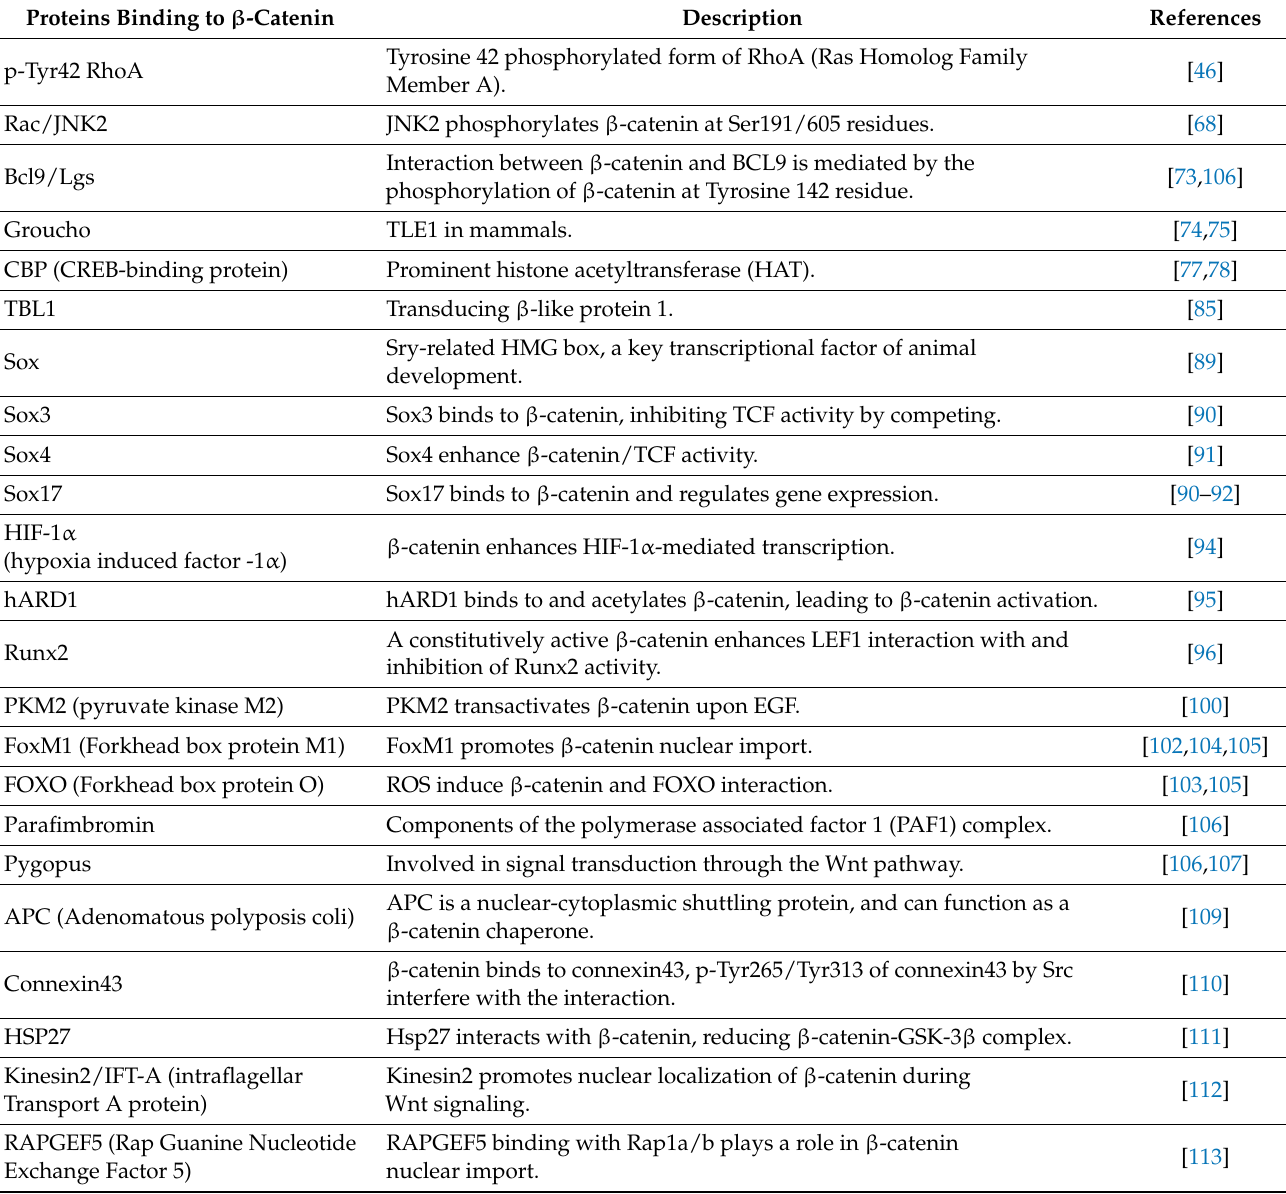
Table 2. Protein factors binding to β